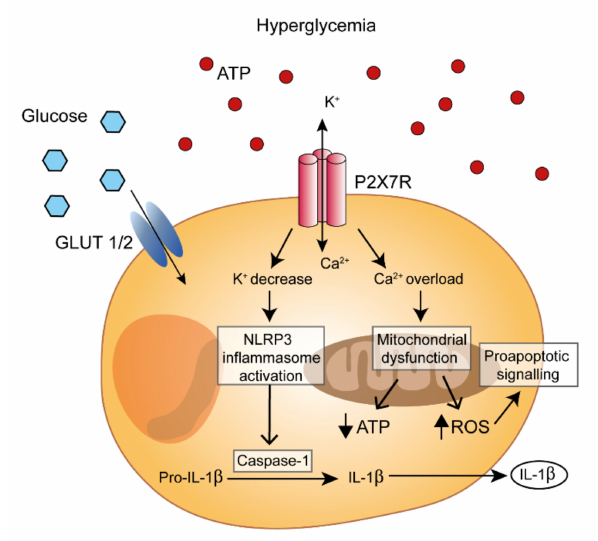
Figure 1. P2X7R modulation of β -cell pro-inflammatory functions. Hyperglycemia promotes eATP release and P2X7R-dependent K + efflux and Ca 2+ influx into the β -cells. Ca 2+ overload promotes mitochondrial dysfunction, reactive oxygen species (ROS) generation, inhibition of ATP synthesis, and eventually triggers apoptosis. Moreover, intracellular K + decrease induces the assembly of the NLRP3 inflammasome, promotes IL-1 β release and further accelerates β -cell